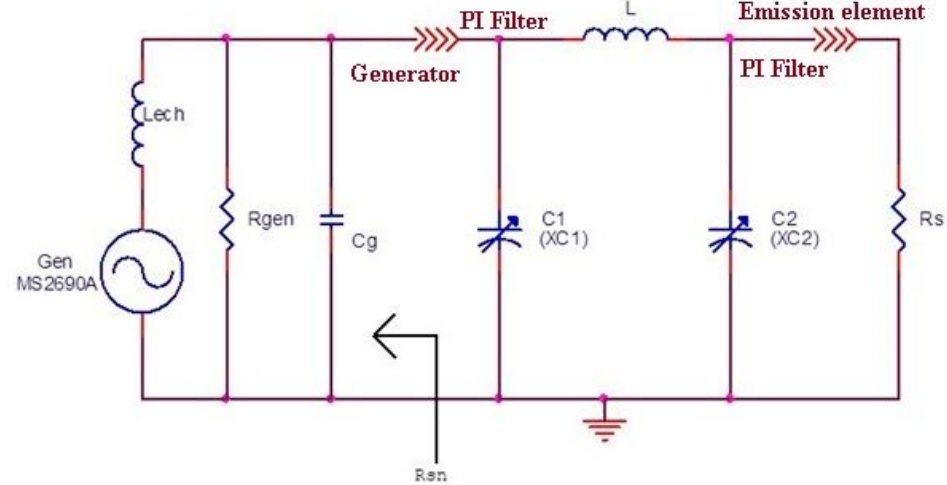
Figure 5. Electrical diagram of the adapter “in Π ”.